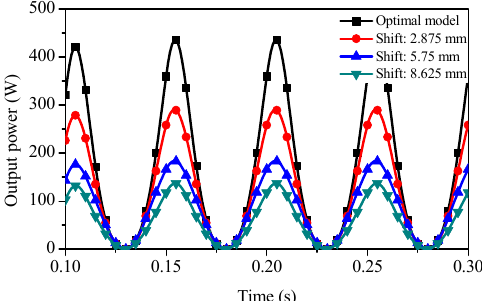
Figure 16. Output power for different shifting lengths.